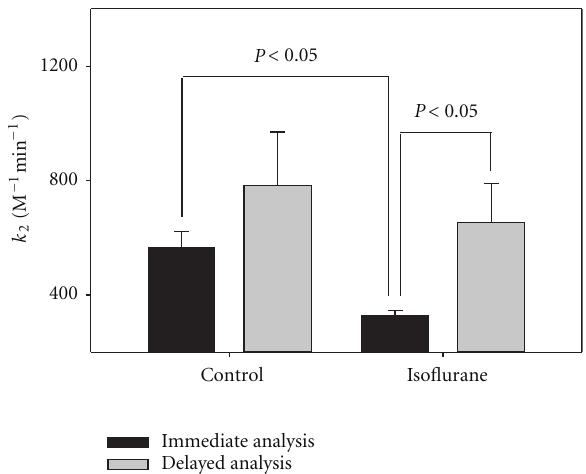
Figure 3: Acetylation of residue Y411. NPA-induced acetylation was measured following dilution of isoflurane-treated HSA. Sam- ples were either analyzed immediately after dilution (black bars) or there was a timed delay of at least 20min following dilution (gray bars). Data are given as mean values ± SEM obtained from multiple